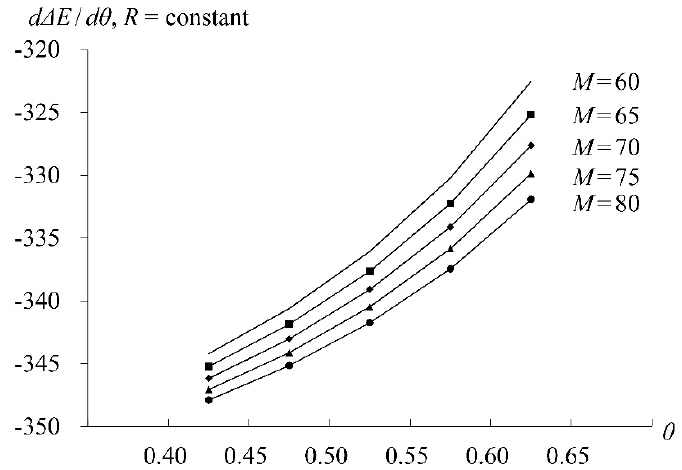
R of 5.60%. The A